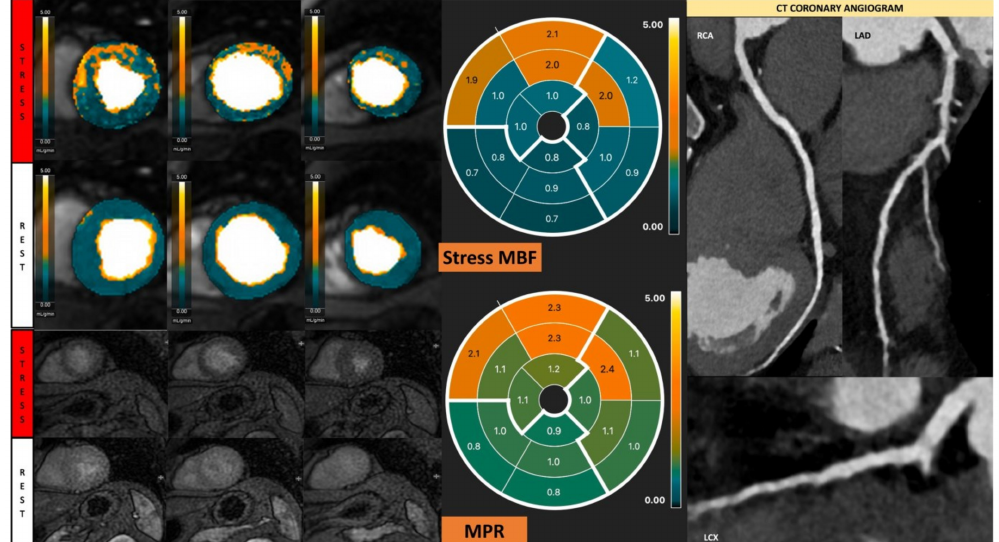
Figure 7. Fully quantitative analysis of stress CMR examination showing coronary microvascular dysfunction. Male, 66 years old, asymptomatic with past history of diabetes, hypertension,